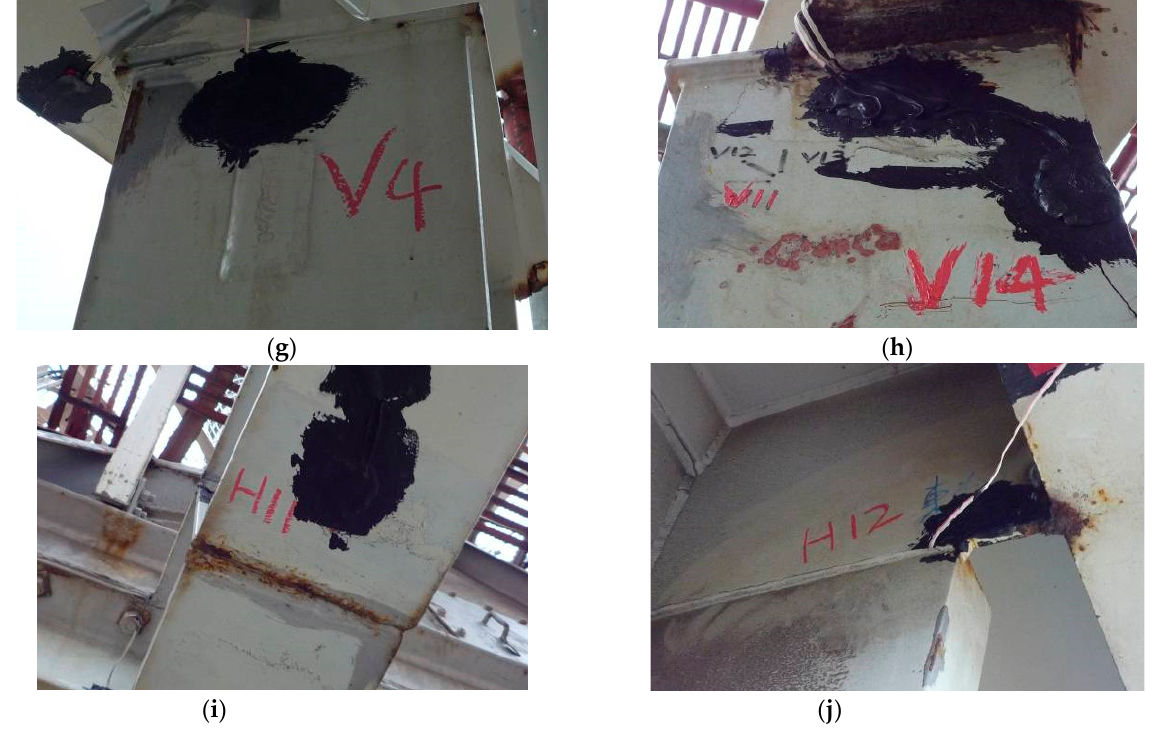
Figure 1. Stress-monitoring positions for the support frame and stack of a petrochemical heater before reinforcement: ( a ) Stress-monitoring positions of the stack (marked by red ellipse); ( b ) Orientation of the stress-monitoring positions of the stack; ( c ) Position G1; ( d ) Position G3; ( e ) Position G5; ( f ) Stress-monitoring positions of the support frame; ( g ) Position V4; ( h ) Position V14; ( i ) Position H11; ( j ) Position H12.